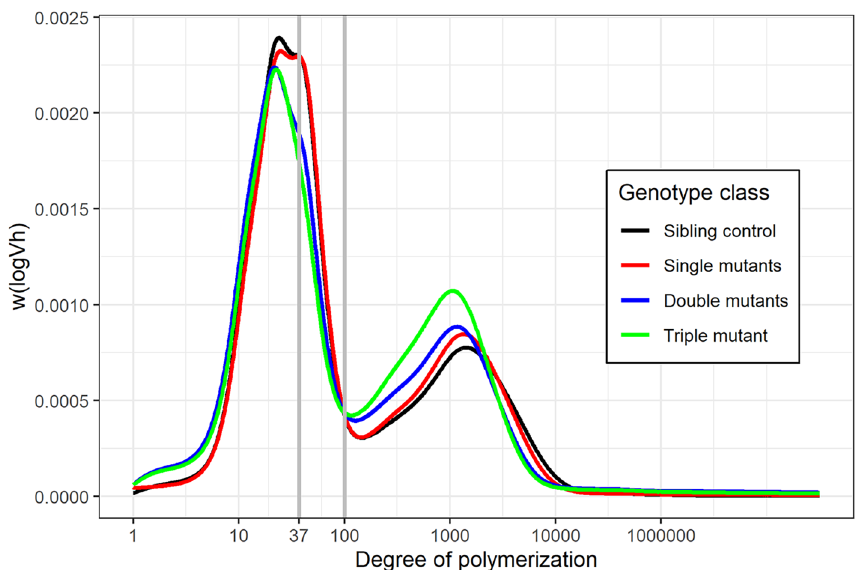
Figure 5. Average chain-length distributions of debranched starch. The y-axis, W(logVh) represents the weight distribution based on the relationship between elution volume and hydrodynamic radius (logVh) for pullulan standards, scaled so that the area under each curve is constant. Each line represents the average for each genotypic class: wild-type sibling control (n = 5), single ssIIIa mutants (n = 15), double ssIIIa mutants (n = 15) and triple ssIIIa mutant (n =